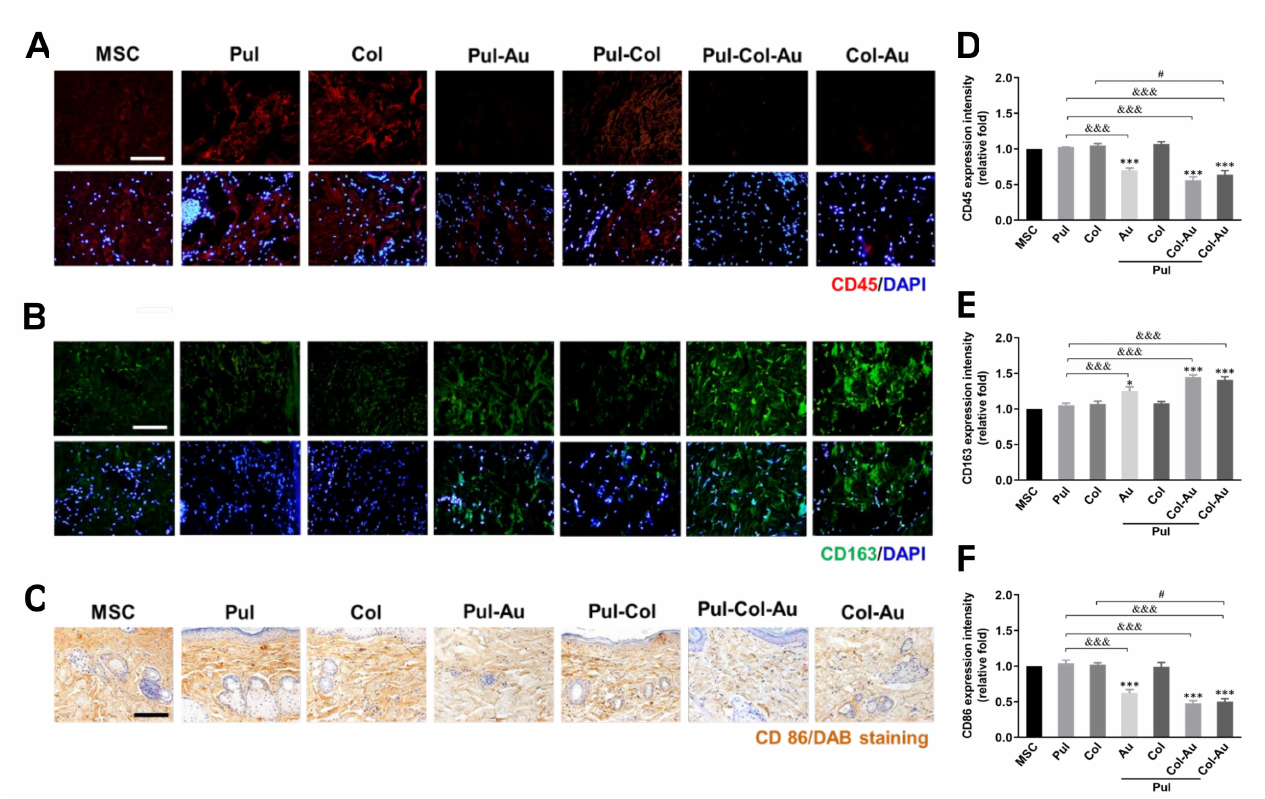
Figure 8. In vivo assessments for leukocyte filtration and macrophage polarization after implanting each material for one month. The immunohistochemistry images for ( A ) leukocyte filtration (CD45, red), ( B ) M2 polarization (CD163, green), and ( C ) M1 polarization (CD86, brown) by DAB staining. The expression of ( D ) CD45 and ( E ) CD163 was semi-quantified based on the fluorescent intensity. ( F ) The DAB positive cells for CD68 were analyzed and quantified the expression. The results indicate the lowest expression of CD45 (~0.56-fold) and CD86 (~0.48-fold), but the highest expression of CD163 (~1.45-fold). Scale bar = 100 µ m. Cell nuclei were stained with DAPI (blue). Data are represented as mean ± SD of the three independent experiments. * p < 0.05, *** p < 0.001: compared to MSC alone group. &&& p < 0.001: compared to Pul group. # p < 0.05: compared to Col